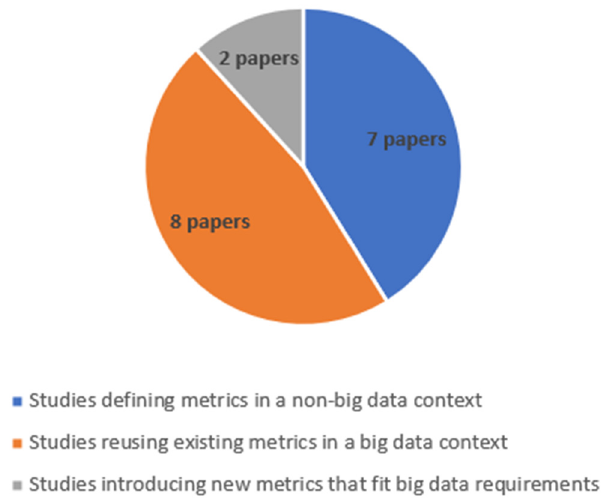
Figure 4. Number of papers corresponding to each type of content.